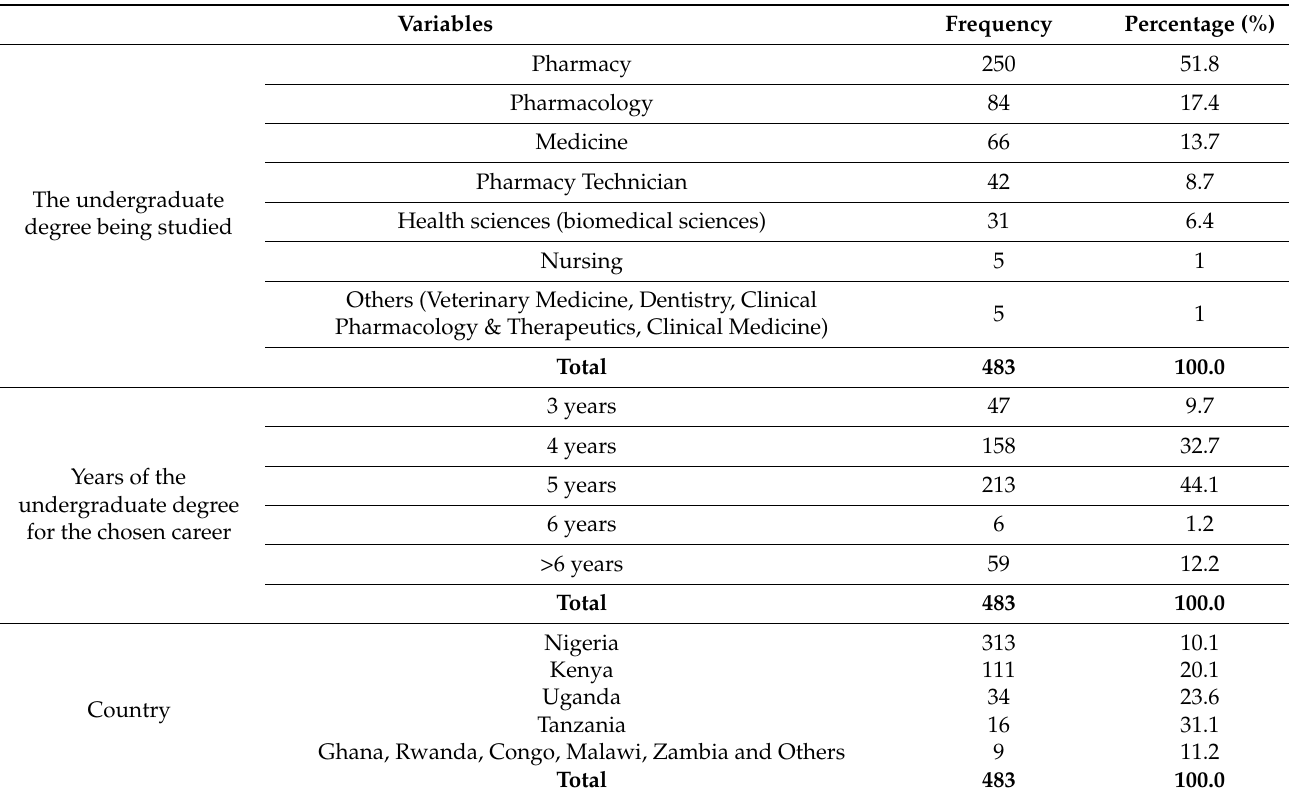
Table 1. Demographics of respondents and countries involved (across 10 Commonwealth